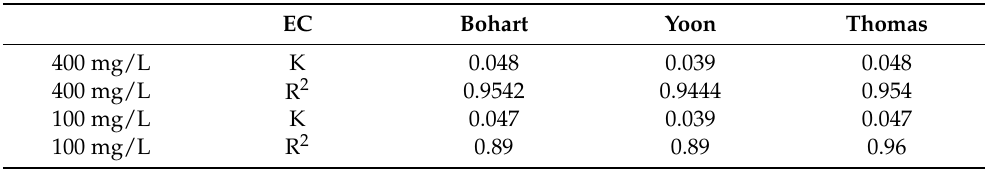
Table 8. Summary of the experiments obtained with EC